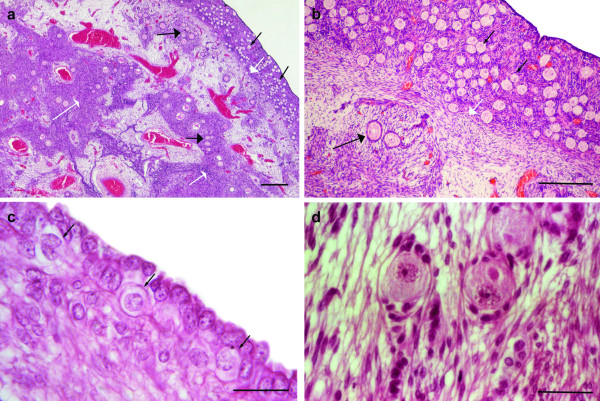
 Sectioned ovary of an elephant fetus at 11 months of gestation.a) Section from the surface epithelium to the central medulla showing small follicles throughout the cortex (small black arrows). The cortico-medullary border is indicated by a white arrow. In the medulla black arrows mark groups of pre-antral follicles while the smaller headed white arrows show areas of interstitial tissue (Scale bar = 500 μm). b) A higher magnification of the cortex and cortico-medullary border (indicated by the white arrow). Small follicles within the cortex are indicated by small black arrows and growing follicles within the medulla by the larger black arrow (Scale bar = 250 μm. c) The surface epithelium of the ovary consisted of a monolayer of cuboidal cells and in places, juxtaposed to these epithelial cells were cells with the size and appearance of oogonia (black arrows; Scale bar = 20 μm). c) Early primary follicles showing the typical prolate shape (Scale bar = 40 μm).